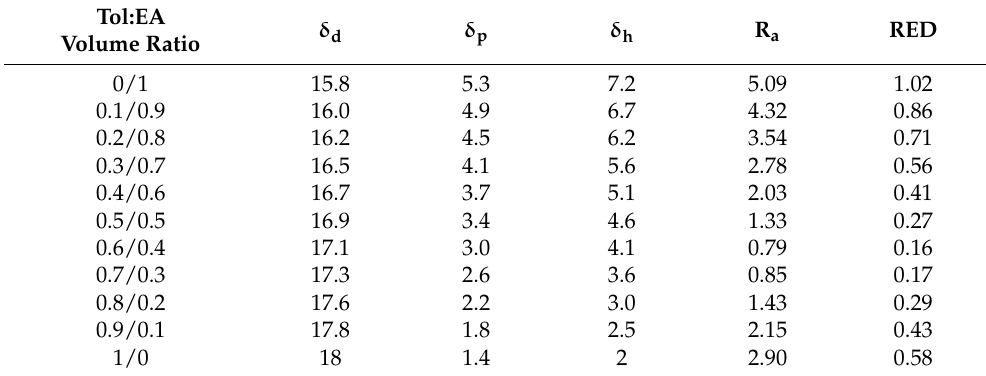
Table 4. Calculated HSPs and RED numbers of binary mixtures of toluene/ethyl acetate.